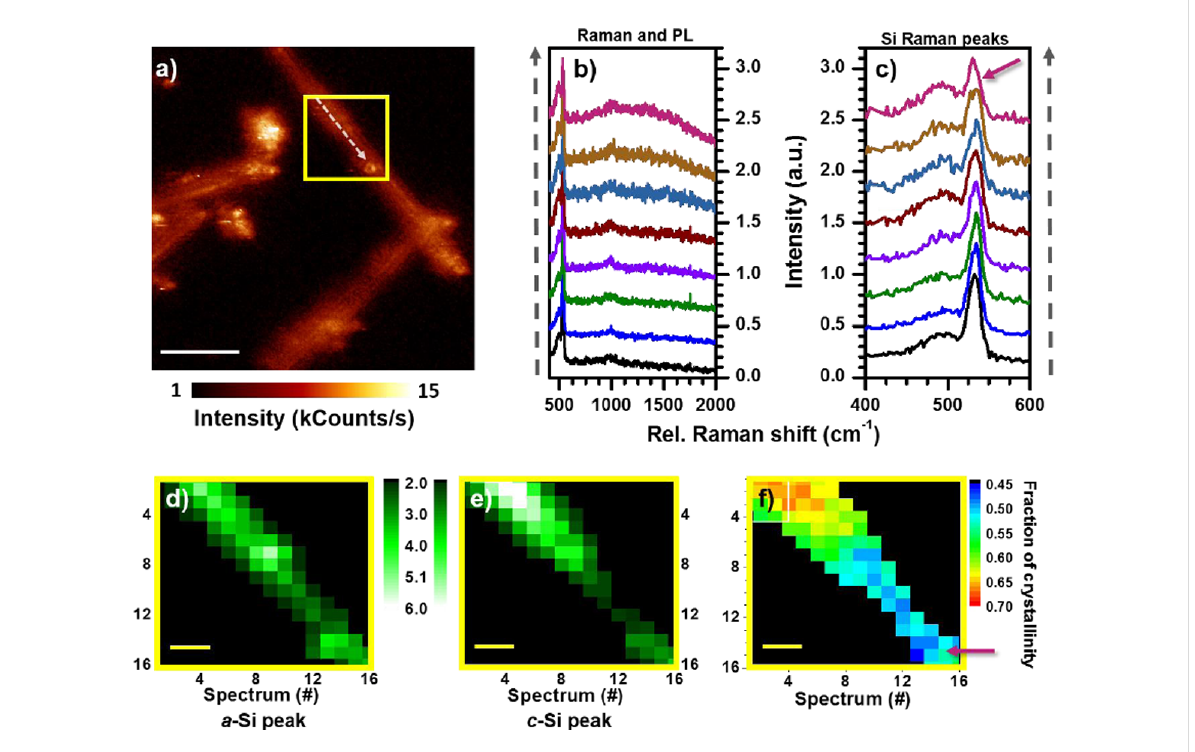
Figure 3: a) Confocal 20 × 20 µm 2 image of two intersecting SiNWs on a gold substrate. The yellow square marks the region where a hyperspectral image with16 × 16 spectra was recorded. b) Raman spectra with PL background were collected along the white arrow inside the yellow square in panel a. c) The evolution in a-Si and c-Si peak intensity along the scan direction shown in panel a. Spectra are vertically shifted for clarity. d) Inte- grated area of the a-Si peak. e) Integrated area of the c-Si peak. f) Calculated fraction of crystallinity. The drop in the fraction of crystallinity at the right bottom corner, corresponds to the ring-shaped pattern inside the yellow square in panel a. Its corresponding spectrum and position are indicated with a pink arrow in panels c and f, respectively. The white scale bar in panel a indicates 5 μ m, and the yellow scale bars are 1 μ m in panels d–f.